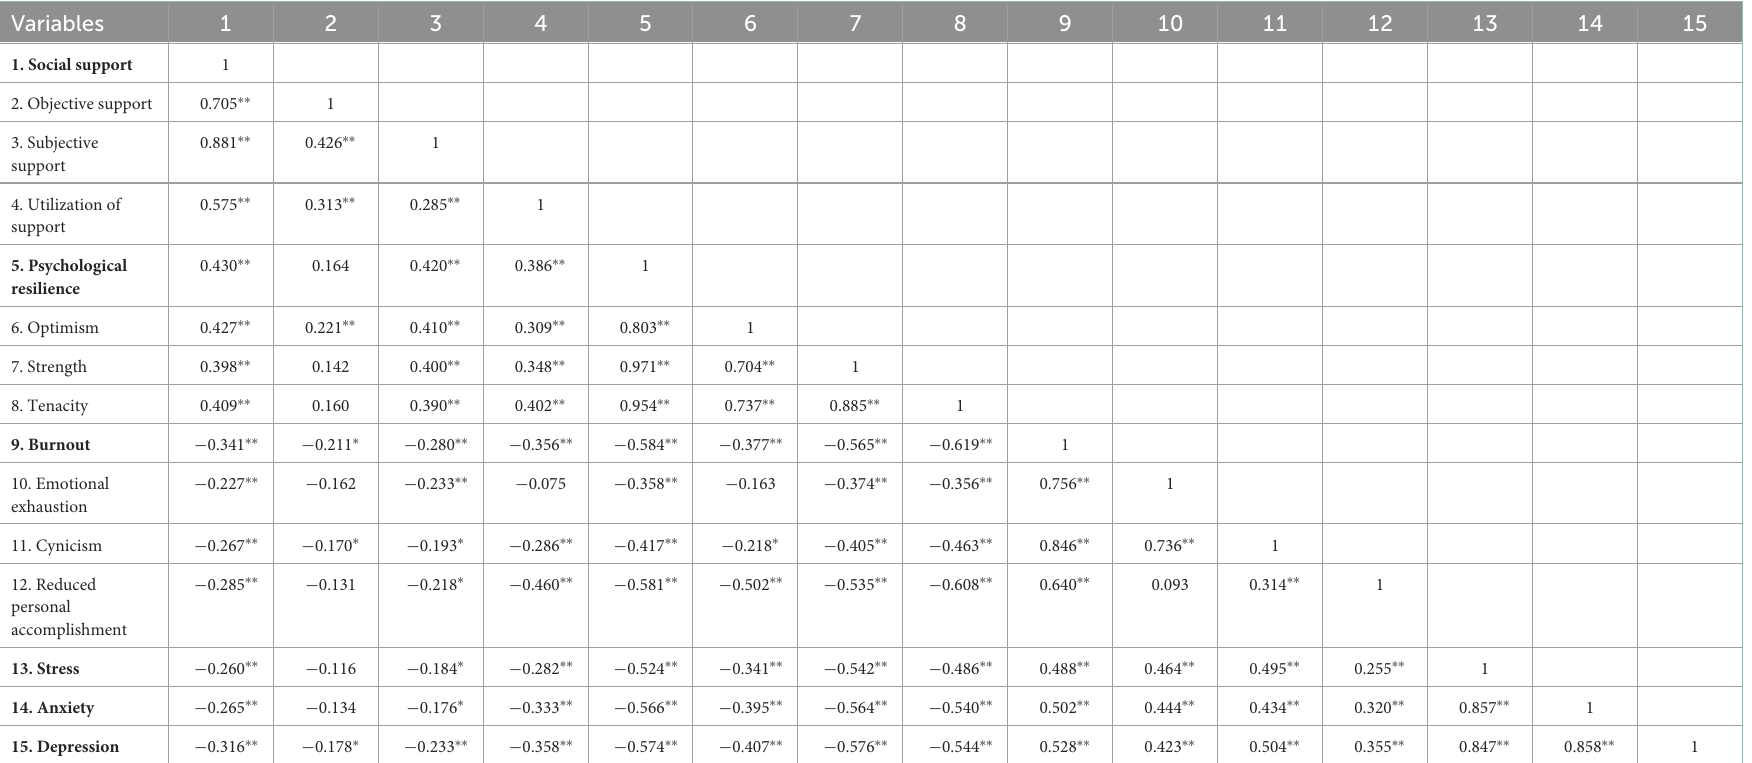
TABLE 3 Correlation